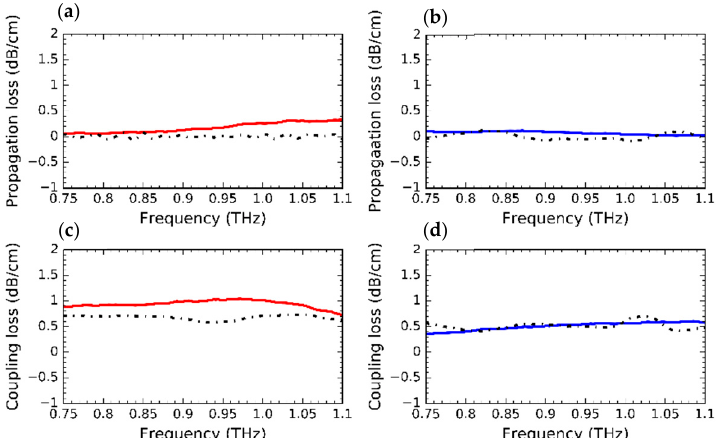
Figure 8. Measured total loss at 0.925 THz as a function of waveguide length: ( a ) Total loss of unclad waveguide; ( b ) Total loss of EM waveguide. The propagation loss is defined using the slope. The coupling loss is defined using the intercept.